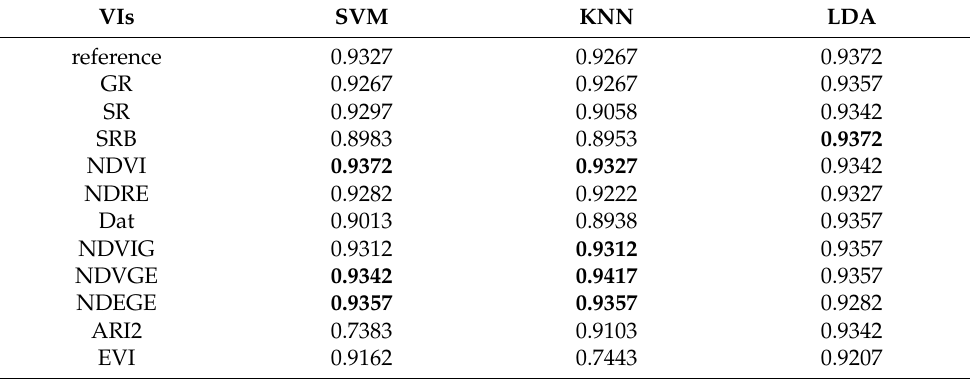
Table 4. The classification accuracy under different classification methods of other VIs, bold refers to those higher than the